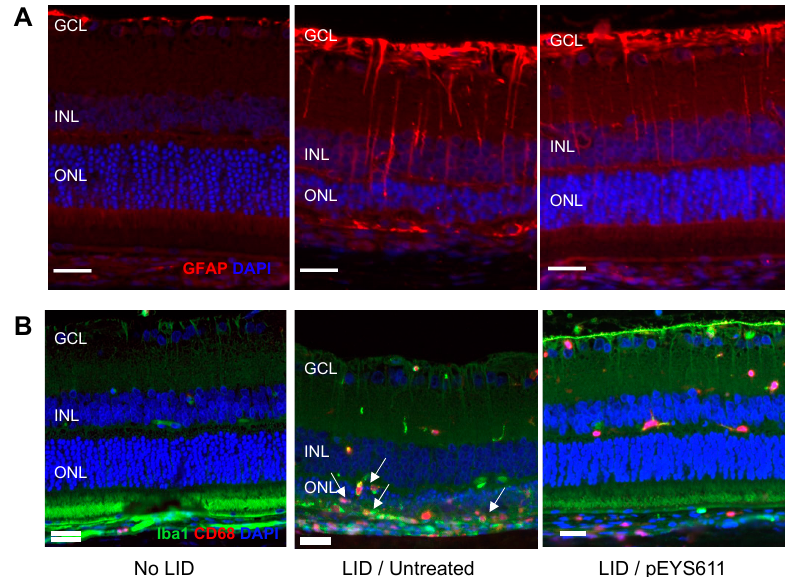
Figure 5. pEYS611 diminishes light-induced macroglia activation and microglia/macrophage retinal migration. Rat received a single ciliary muscle electrotransfection of pEYS611 (30 µg/eye) on D-3 or left untreated ( n = 8 animals/group). Except for unexposed animals (no LID), retinal degeneration was induced on D0 by 24 h of bright light exposure (6500 lux). anti-Glial fibrillary acid protein (GFAP) and Iba1/CD68 staining was performed on D8. ( A ) Representative images of GFAP staining (red) in the inferior central part of the retina. ( B ) Representative images of Iba1 (green) and CD68 (red) immunostaining in the inferior central part of the retina. Arrows indicate microglial cells and macrophages accumulating in the outer retina of LID/untreated animals. Scale bar, 25 µm. GCL, ganglion cell layer; INL, inner nuclear layer; ONL, outer nuclear layer.